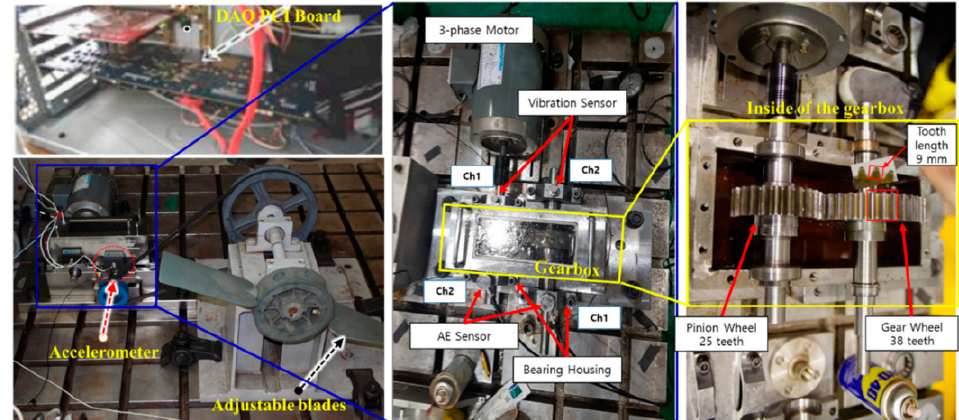
Figure 1. Experimental testbed arrangement for acquiring the MTCG gearbox dataset.